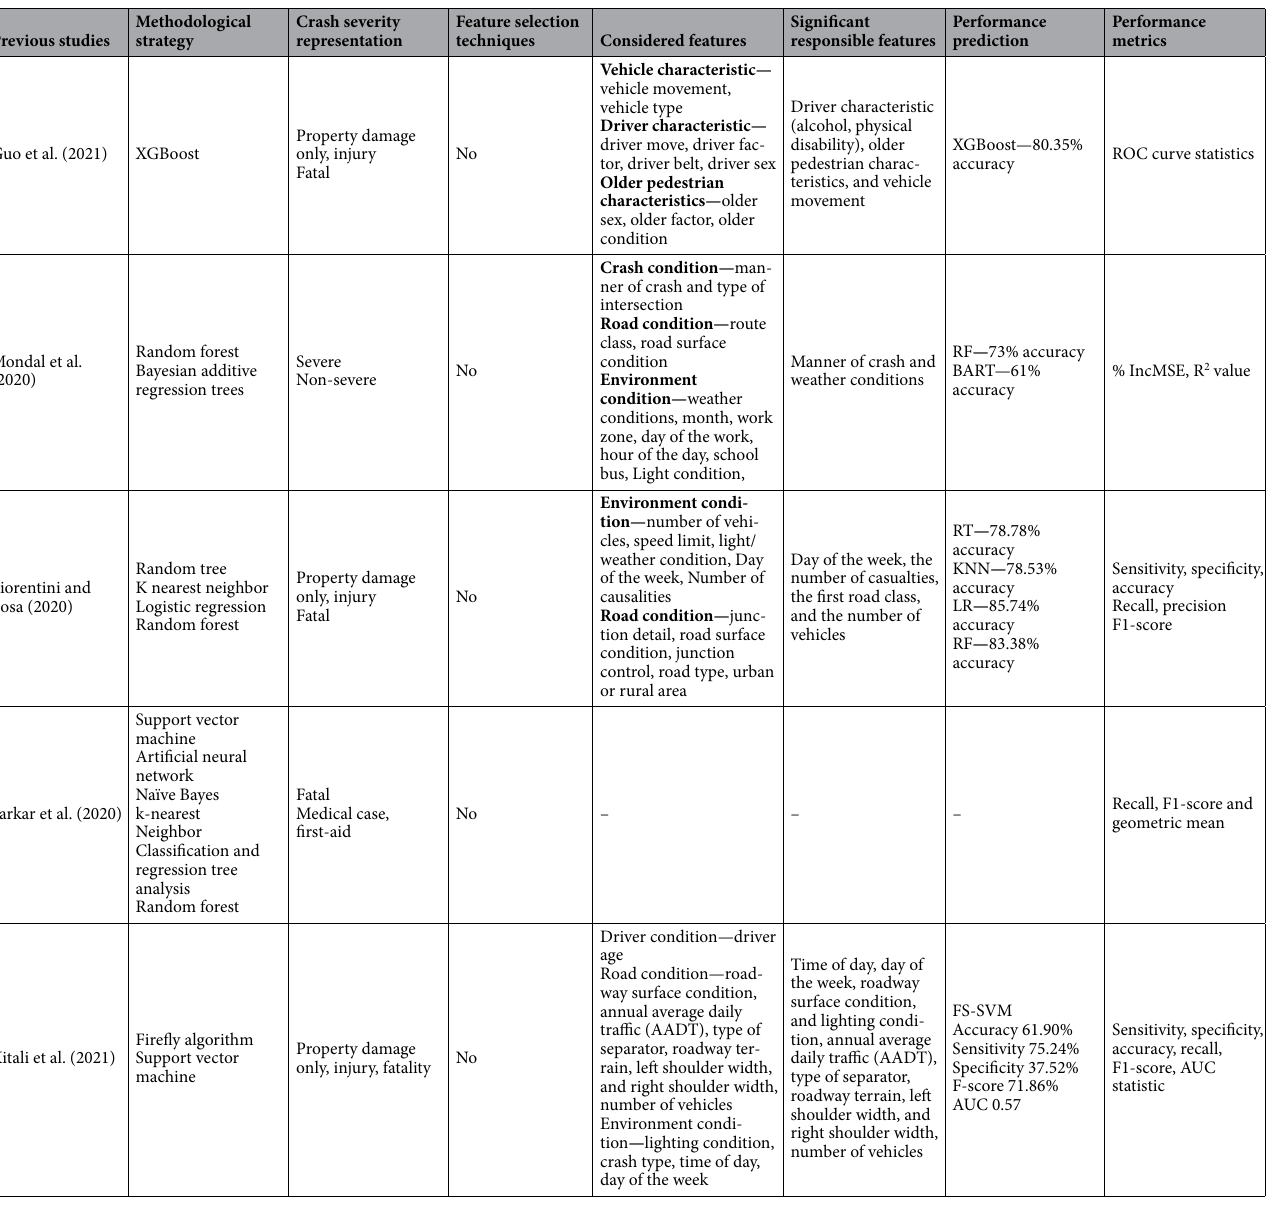
Table 1. Summary of previous crash severity analysis and prediction